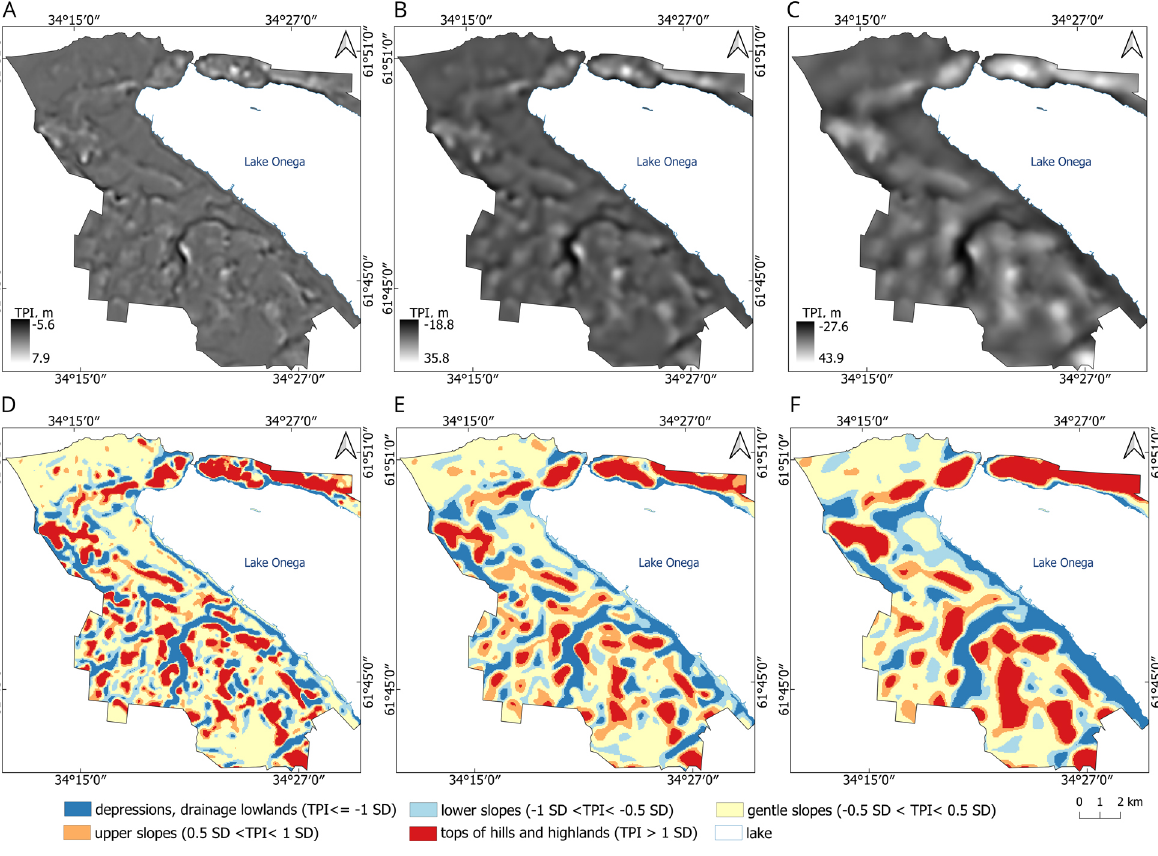
Fig. 4. Topographic position index